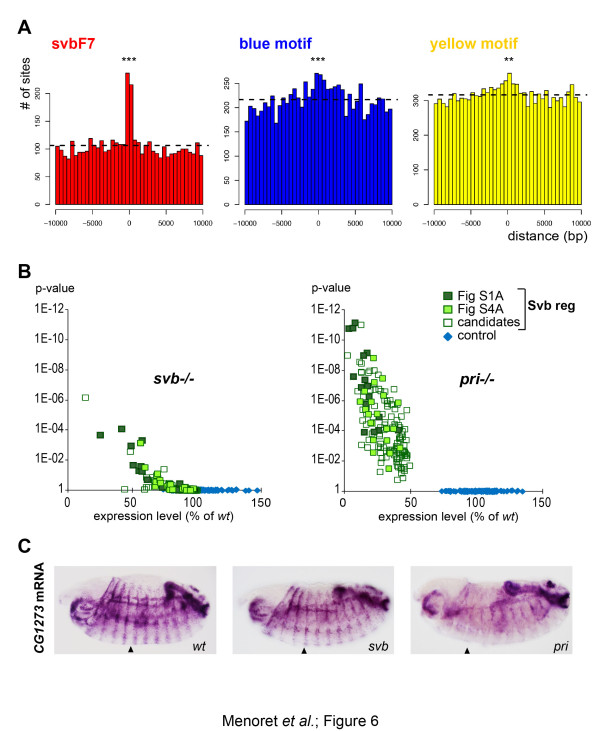
Genome-wide profiling of embryonic genes regulated by Svb. (a) Cross-correlation between conserved svbF7, blue or yellow motif instances and Svb ChIP-seq peaks throughout the whole genome. Plots show the number of motifs found in a 10 kb window on each side of the center of peaks. The P-value for correlation (Chi2 test) is <1E-46, <1E-9 and <1E-2 for svbF7, blue and yellow motifs, respectively. *** indicates a P-value < 0,001, ** < 0,01. Dashed line shows the average number of sites across the region. (b) Modifications in mRNA levels as measured by microarrays between wild-type (wt) and svb (left) or pri (right) embryos in Svb-regulated (green) and control (blue) sets of genes. Dark green dots represent known Svb targets (Figure S1A in Additional file 1), light green novel target genes as validated by in situ hybridization (Figure S4 in Additional file 1) and open dots additional candidates. (c) Whole mount in situ hybridization of CG1273, a Svb downstream target identified from microarray profiling, down-regulated in trichome cells (arrowheads show a raw of ventral trichome cells) of svb mutants and showing further reduced expression in pri mutant embryos.